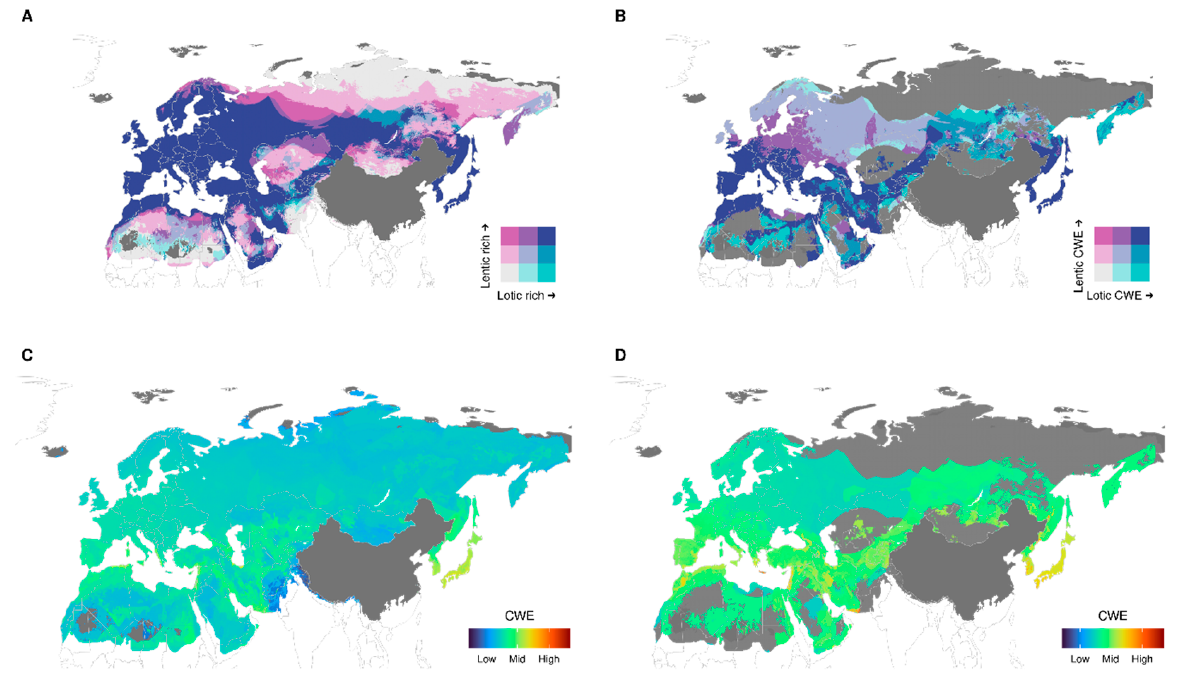
Figure 2. Species richness and corrected weighted endemism for aquatic habitats used by odonate species in the Palaearctic. ( A ) Bivariate plot showing distribution of richness for lotic-dependent and lentic species; ( B ) bivariate plot showing distribution of corrected weighted endemism (CWE) for lotic-dependent and lentic species; ( C ) corrected weighted endemism (CWE) for lentic species; and ( D ) corrected weighted endemism (CWE) for lotic-dependent species.